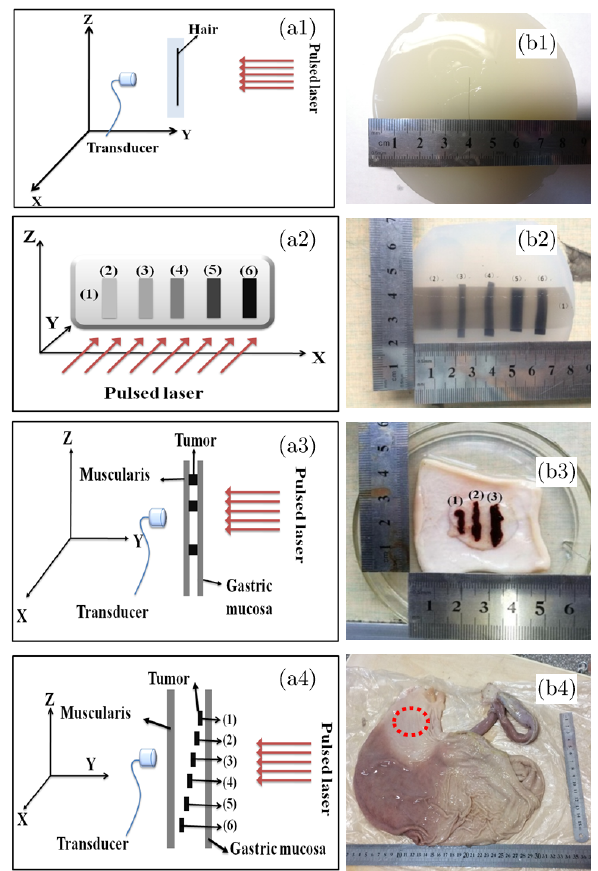
Fig. 3. Schematic diagram of experimental model. (a1) and (b1): the model for detecting the transversal and vertical resolutions of the PAI; (a2) and (b2): the model for detecting of the sensitivity of PAI; (a3) and (b3): the model for detecting the simulated gastric tumor in transversal detection; (a4): the model for detecting the simulated gastric tumor in longitudinal detection; (b4): the front view of porcine stomach interior sample, gastric mucosa and muscularis are from ROI of